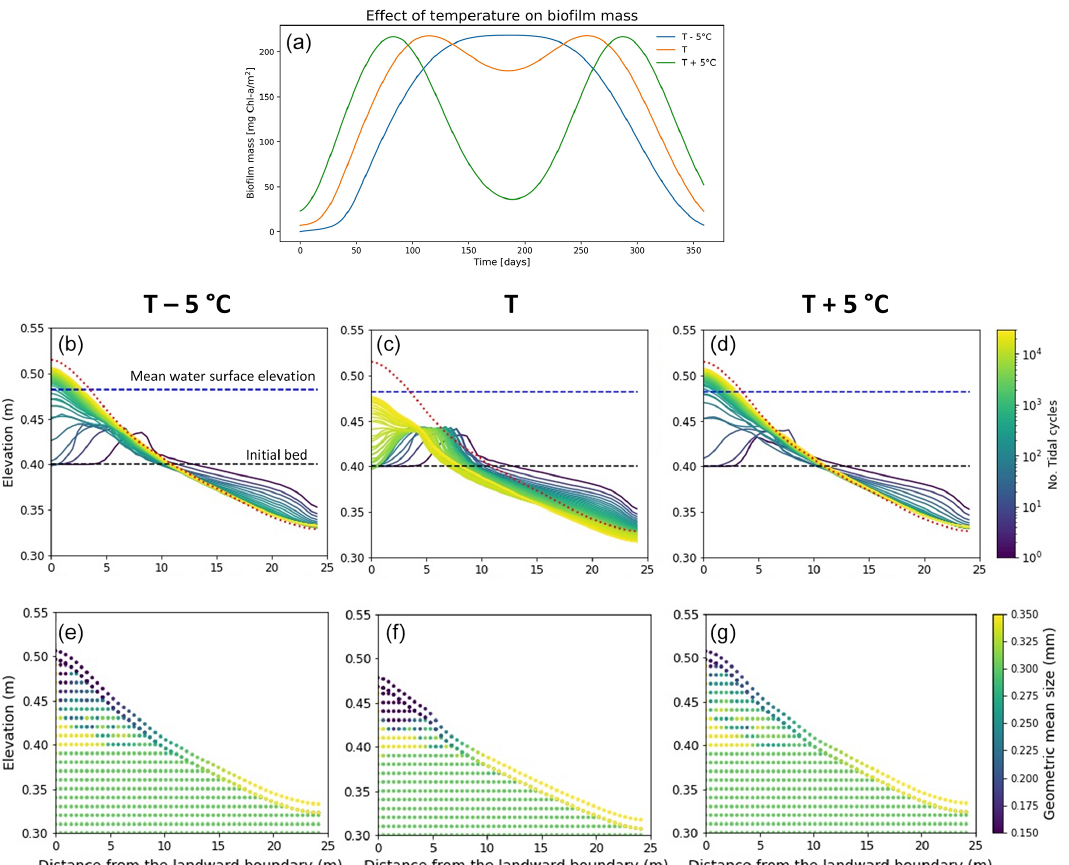
Figure 7. Effect of sediment temperature on the development of biofilm (a) . Bed evolution profile (b, c, d) and final stratigraphy of the deposit (e, f, g) after 30000 tidal cycles in the case of low sediment temperature ( − 5 ◦ C, left panels), the reference case (centre panels) and high sediment temperature ( + 5 ◦ C, right panels). The bed profiles are compared with the clean sediment final bed elevation at equilibrium (dashed red lines). The dashed blue and green lines represent the initial water surface elevation and the initial bed profile, respectively. The initial geometric mean size of the bed is